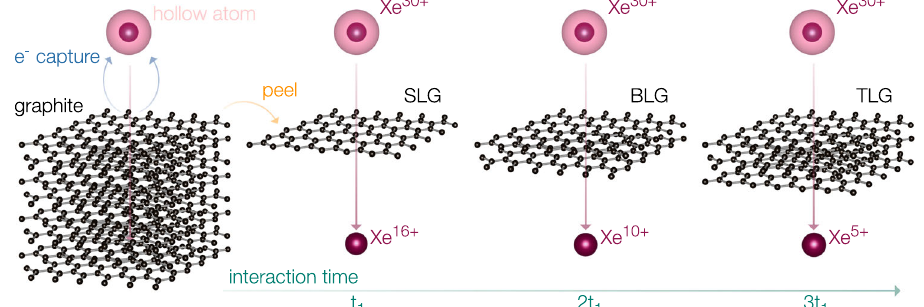
Fig. 1 Schematic of the interaction of highly charged ions and (atomically thin) materials. While for a bulk material information on the ion ’ s charge state is unattainable after the ion enters the material, ions can be detected after transmission for atomically thin material layers. In this work, we peel graphite layer by layer and thus study the interaction of highly charged Xe ions and single-layer (SLG), bilayer (BLG) and trilayer graphene (TLG) to gain an understanding of the charge exchange dynamics of ions inside a solid. Even before reaching the material, approaching ions resonantly capture electrons from the material and a hollow atom is formed 38,56,57 . De-excitation of such hollow atoms in close proximity to the material layer further dominates the interaction processes. Exemplary charge states are (approximately) taken from Supplementary Information Fig. S1 and were found in experiments using 116 keV Xe 30 + as a projectile. Graphene layers were rendered using the software VESTA 82 .